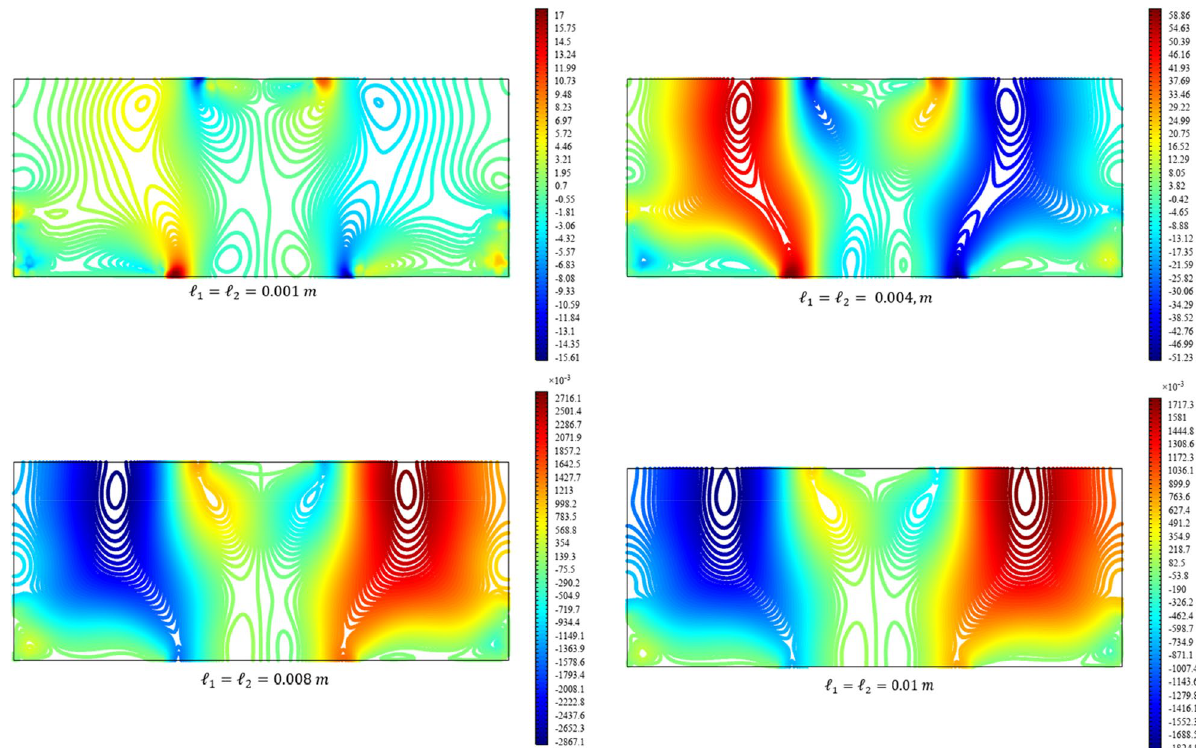
Figure 7. Surface plot for the micro-strain s xy